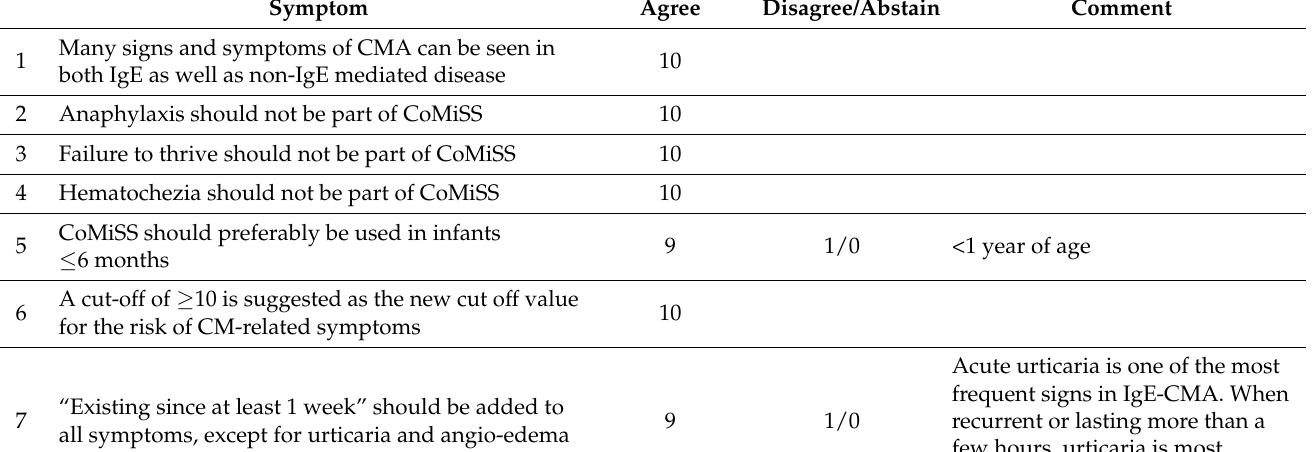
Table 3. Statements and voting results regarding the updated